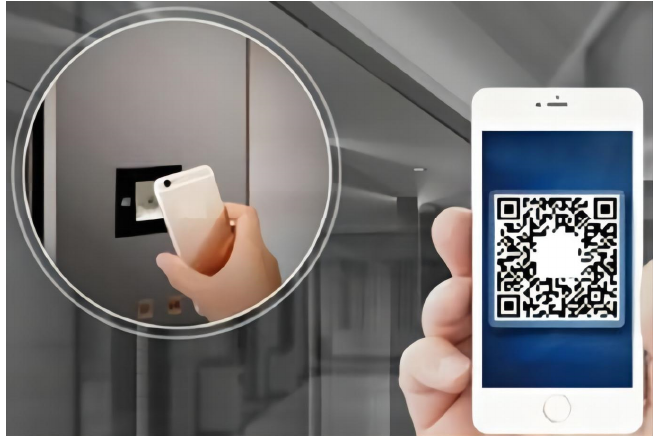
Figure 4. Mobile phone QR code to call elevator in a building.